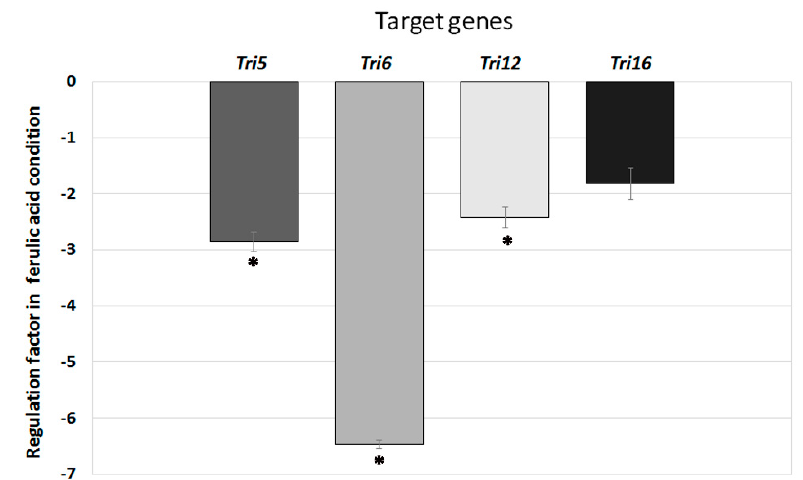
Figure 4. Regulation factors obtained for Tri genes in culture supplemented with ferulic acid relative to the control culture. The sign * indicates a significant regulation according to t -test ( p < 0.05).